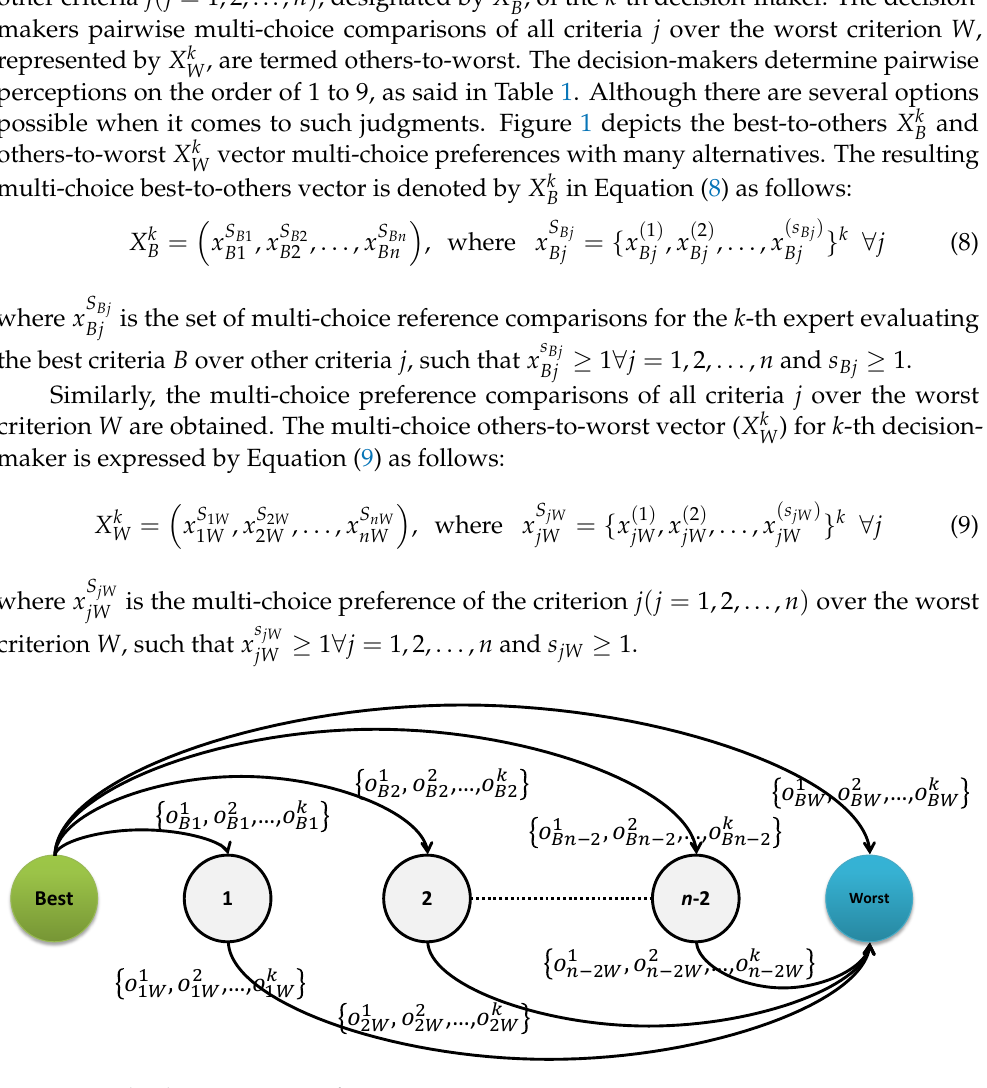
Figure 1. Multi-choice pairwise reference